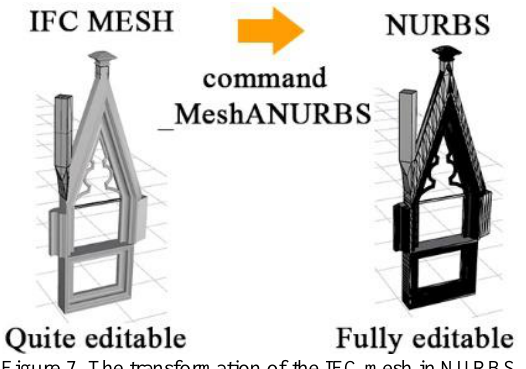
Figure 7. The transformation of the IFC mesh in NURBS.